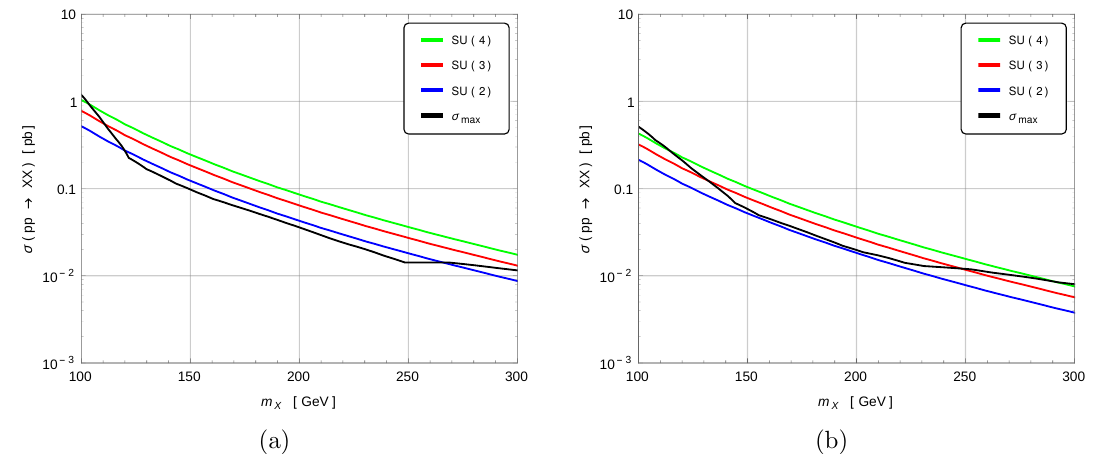
Figure 4. Upper limits at 95% CLs on the cross section of pair production of (a) X S X S from the LHC stau search of ref. [49] and r inv ! 1. Cross sections are also presented for G E c corresponding to di(cid:11)erent SU( N